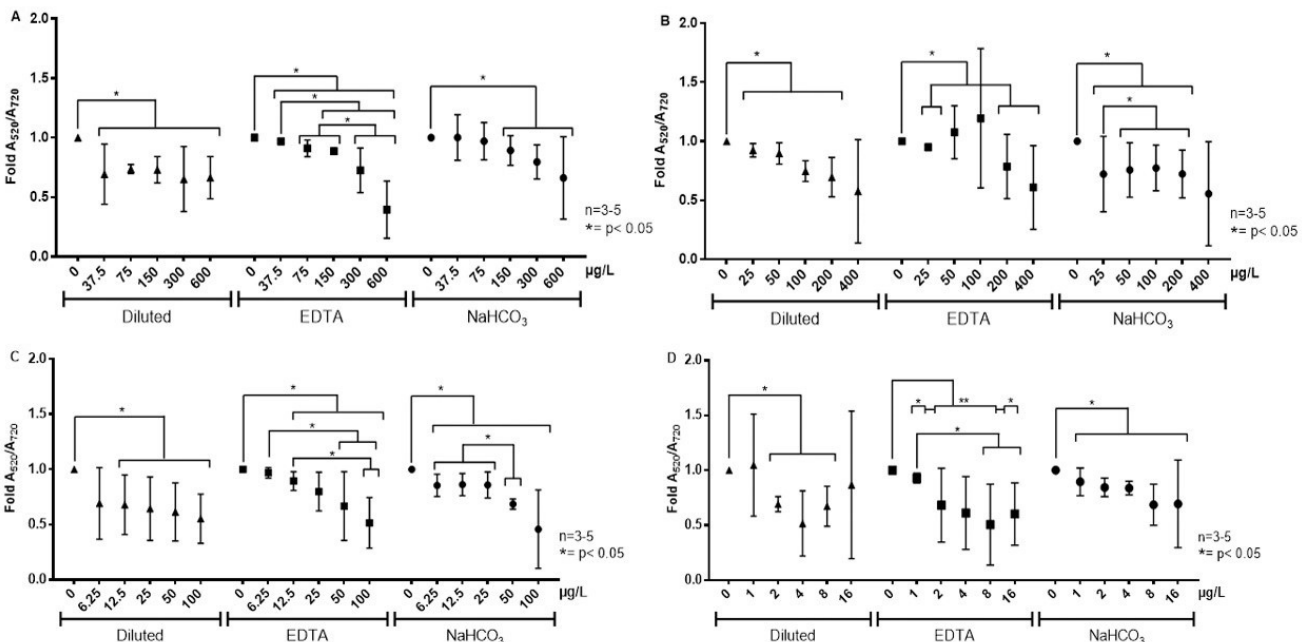
Figure 8. Colorimetric detection of antibiotics in cation-removed milk whey with NAS specific for ( A ) kanamycin, ( B ) oxytetracycline, ( C ) sulfadimethoxine and ( D ) ampicillin. The interferents were removed by dilution ( ▲ ), EDTA treatment ( ◼ ) and NaHCO 3 treatment ( ⚫ ). The results were averaged from three independent experiments ( n = 3). Statistically sig- nificant differences compared with the controls and different treatments are indicated. * p < 0.05 and ** p < 0.01.